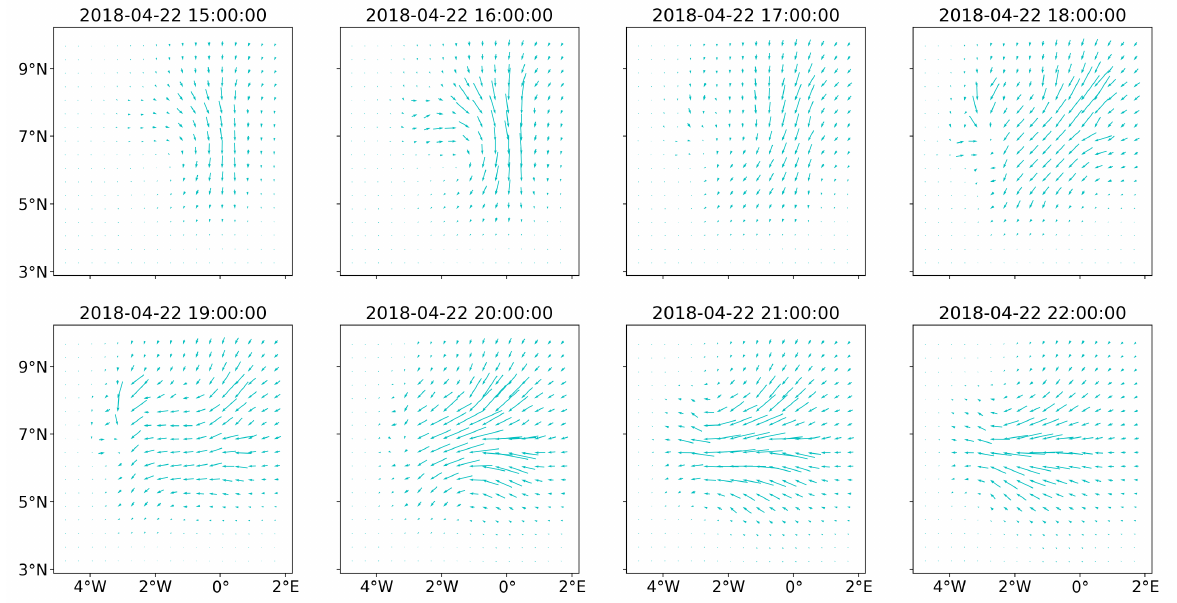
Figure 11. Average mappings obtained from the LOOV. The mappings were average over the 65 realizations of the LOOV. For the sake of clarity, we only show the mapping at some selected time steps. At the other time steps, the distortion was much smaller or null, due to the absence of precipitation in the target field v .